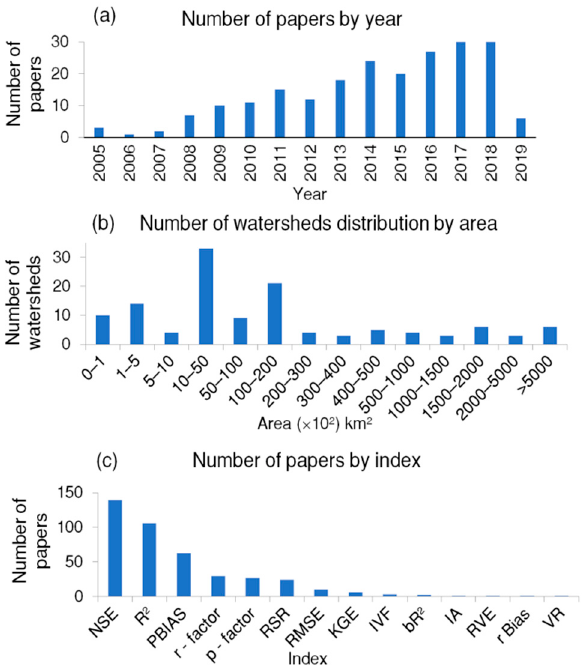
Figure 3. Number of papers by year, watershed distribution by area, and number of papers by in- dex.